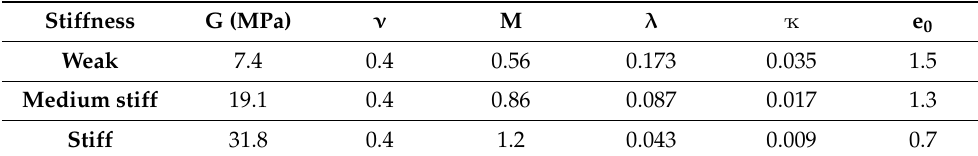
Table 3. The MCC model’s subgrade layer